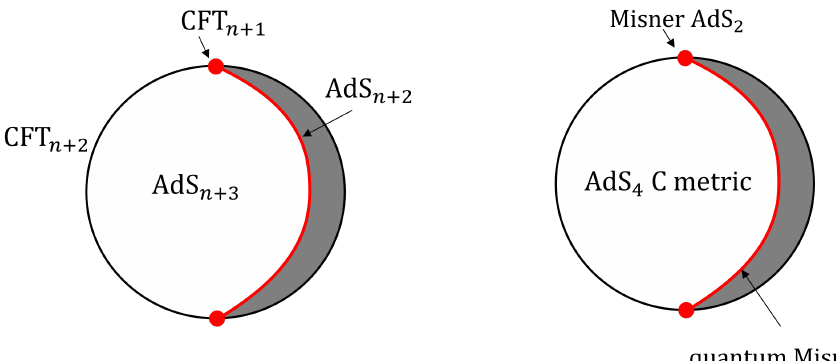
Figure 1 . Double holography. The red line is the brane, and the gray region is excluded. Left: general setup ( n ≥ 0 ). Right: geometries involved in the realization in this article ( n = 1 ). The classical 4D bulk differs from empty AdS 4 and in this way gives rise to quantum bulk corrections to Misner-AdS 3 (section 4), which in turn are interpreted as 1 /c corrections to the CFT 2 in Misner- AdS 2